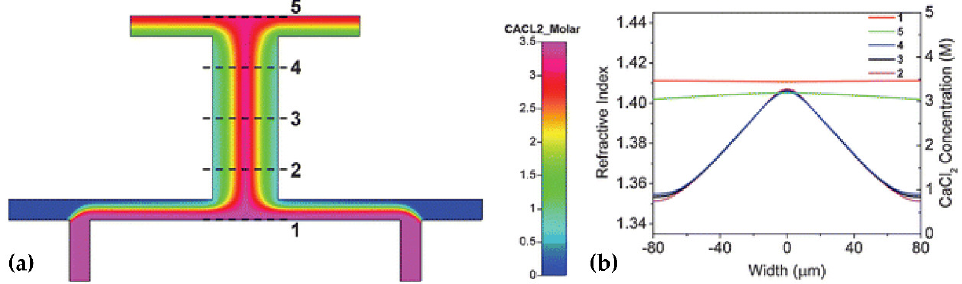
Figure 3. Simulated refractive index profile due to the diffusion [42]. ( a ) Simulated model and distribution graph. ( b ) Cross-sectional refractive index distribution at different locations along the flow direction (1, 2, 3, 4 and 5, as indicated in ( a )). Reprinted with permission from Ref. [42]. 2009 Royal Society of Chemistry.